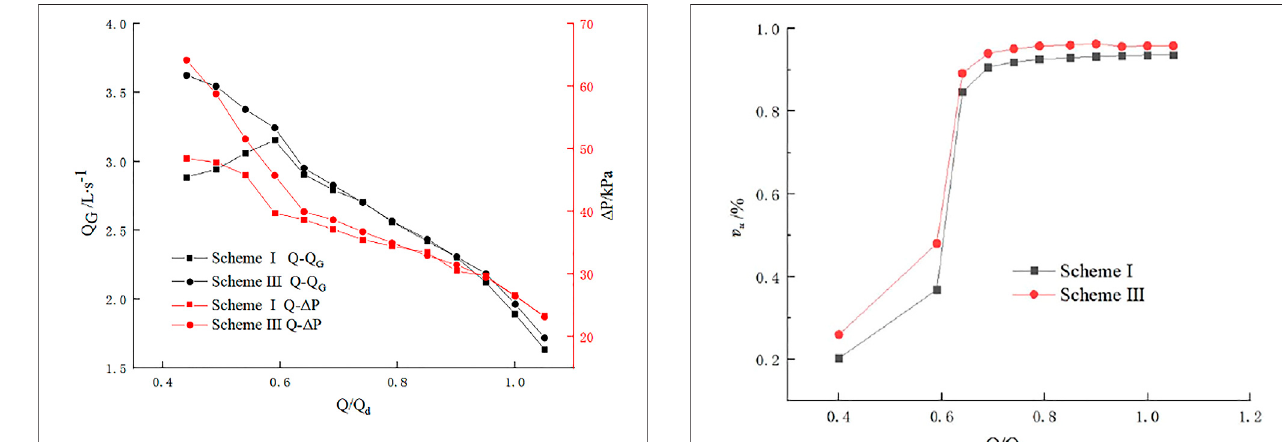
FIGURE 10 | Gap back fl ow and pressure difference between impeller inlet and outlet under all working conditions.